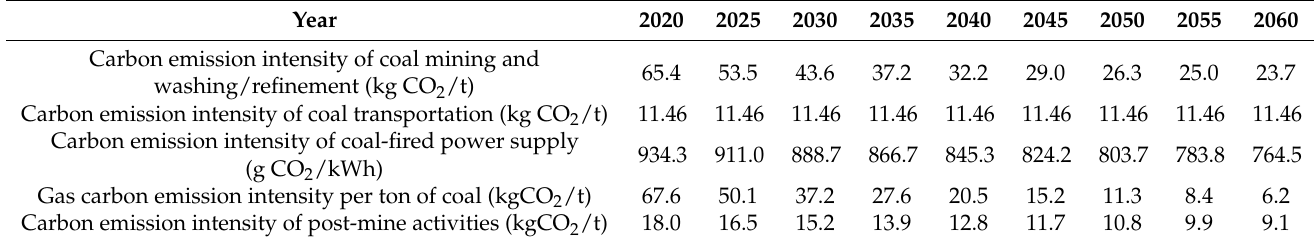
Table 5. Prediction of the future trend in carbon emission intensity life cycle coal electricity production.